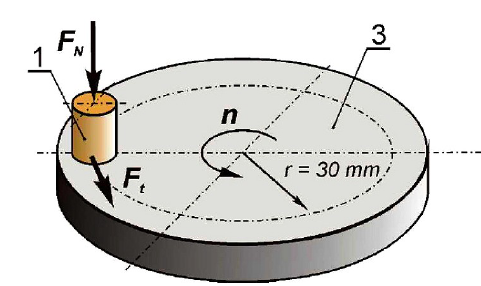
Figure 1: Scheme of pin-on-disc